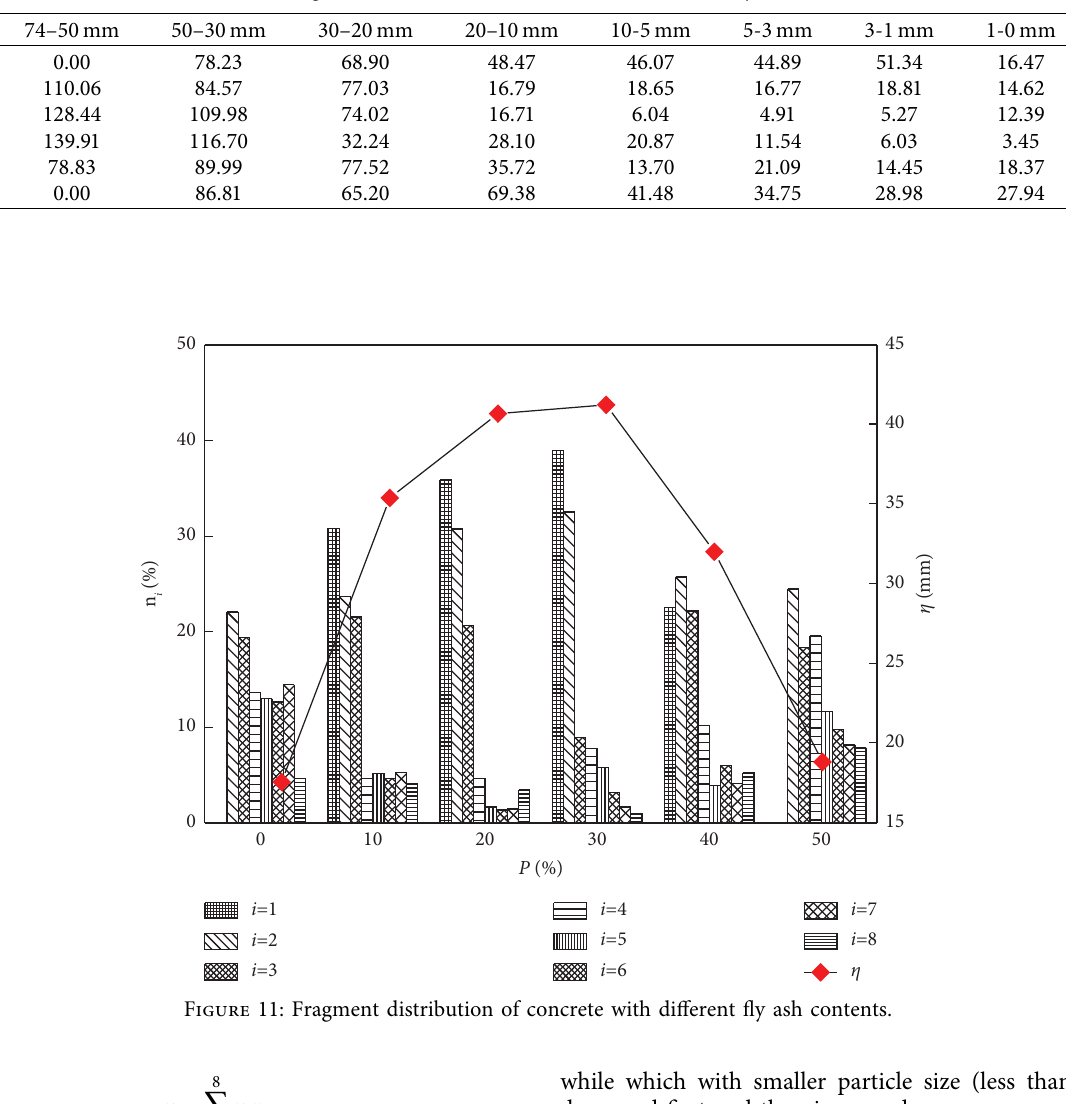
Table 4: Fragment distribution of concrete with diferent fy ash contents.